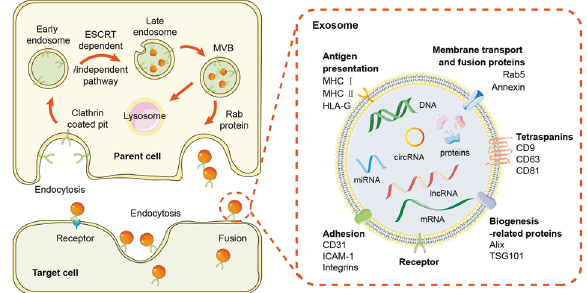
Fig. 2 The biogenesis and release of exosomes. Exosome biogen- esis begins with early endosome formation through endocytosis at the plasma membrane. The membrane receptors are internalized through clathrin-coated pits and delivered to early endosomes. By ESCRT dependent or independent pathway, the endosomal mem- brane buds inward to form exosomes, and then early endosomes mature into MVBs. Through this process, exosomes contain a variety of factors including DNA, RNA, and intracellular proteins. Exosomes in MVBs are delivered to lysosomes for degradation or fused with the plasma membrane via the Rab proteins for release to the extracellular space. After secretion, the recipient cell mediates uptake of exosomes through endocytosis, fusion with the plasma membrane, or ligand/ receptor interaction. ESCRT Endosomal sorting complexes required for transport, MVB multivesicular